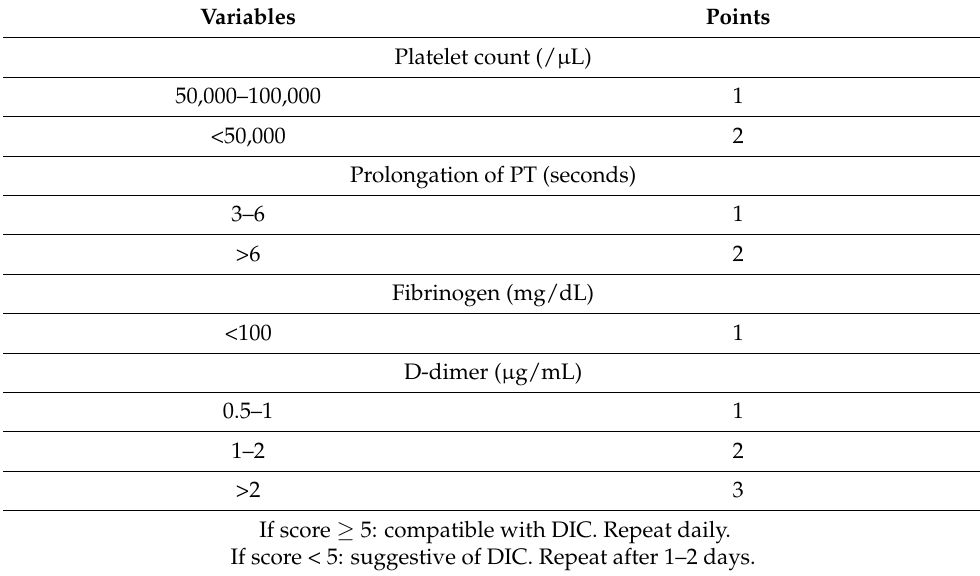
Table 5. DIC-Score by ISTH